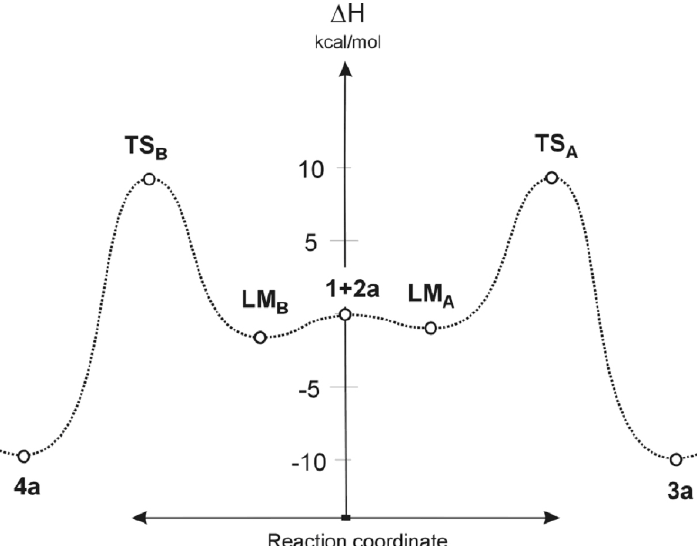
Figure 5. Enthalpy profiles for [2+3] cycloaddition reaction between 1-chloro-1-nitroethene 1 and (Z)-C-(p-methoxyphenyl)-N-phenylnitrone 2a in chloroform according to B3LYP/6-31G(d) (PCM) calculations (298 K).